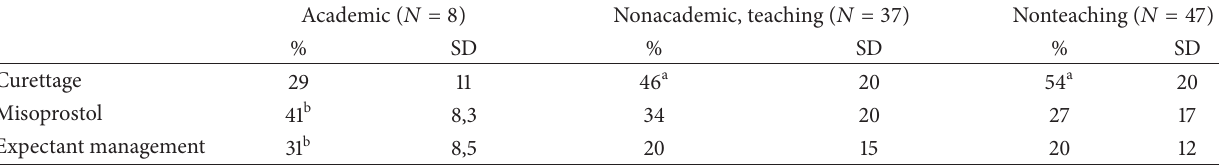
Table 1: Mean number of patients (in percentages) per different treatment options.